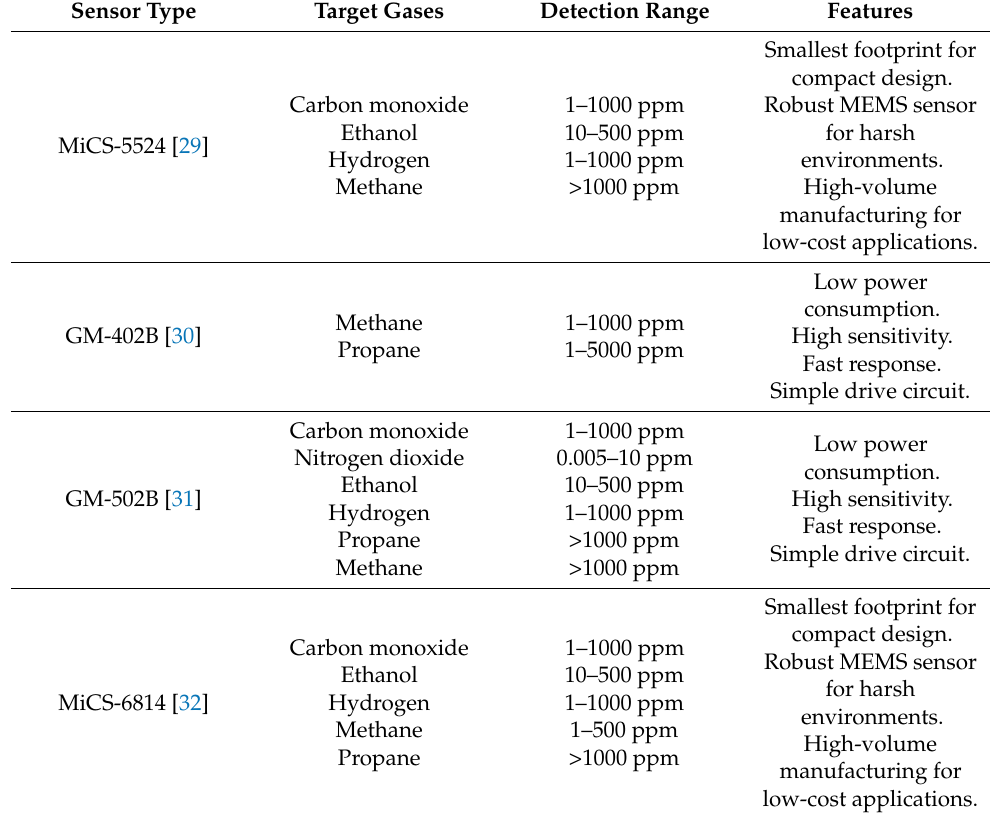
Table 1. Type of gas sensors for the PCB